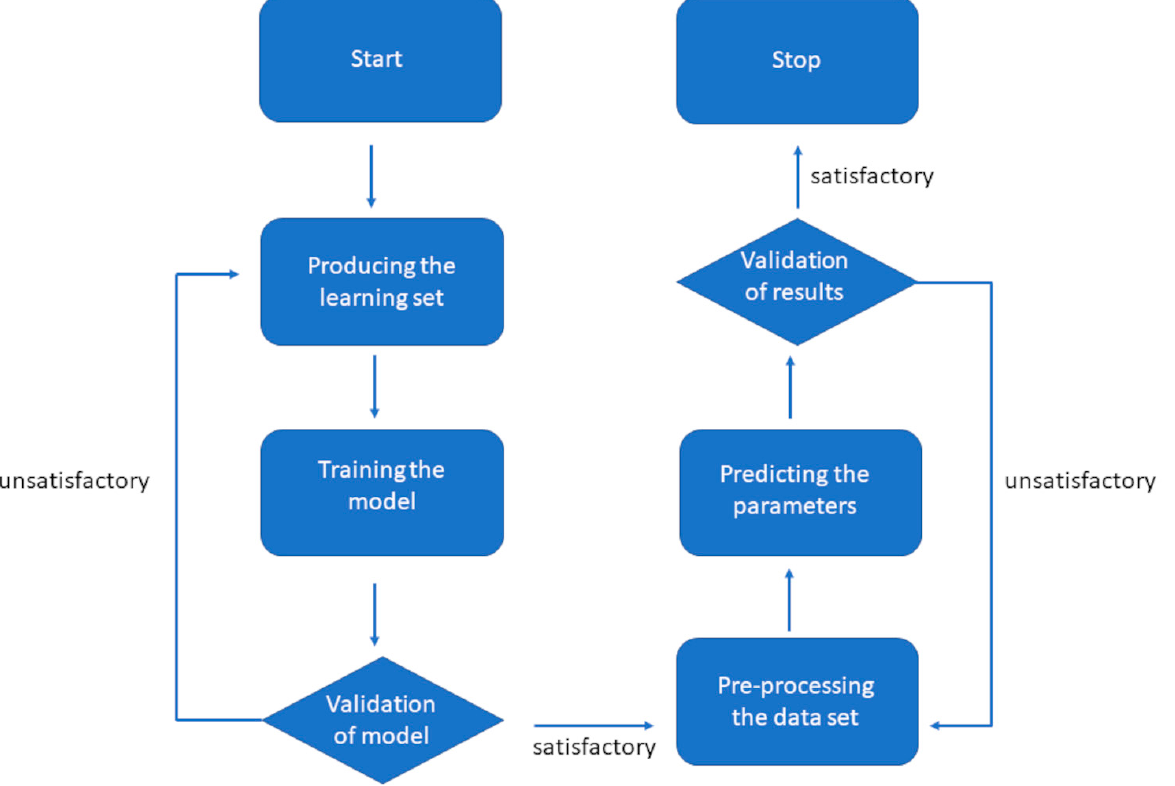
Figure 3. Flowchart of the ML-XLPA procedure.